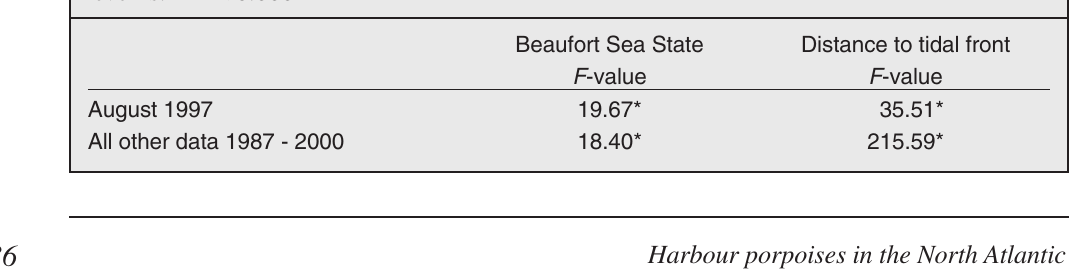
Table 1. Test of significance of linear relationship (general linear model) between the log- density of harbour porpoises and Beaufort sea state and distance to tidal front. Significance level is: * P <